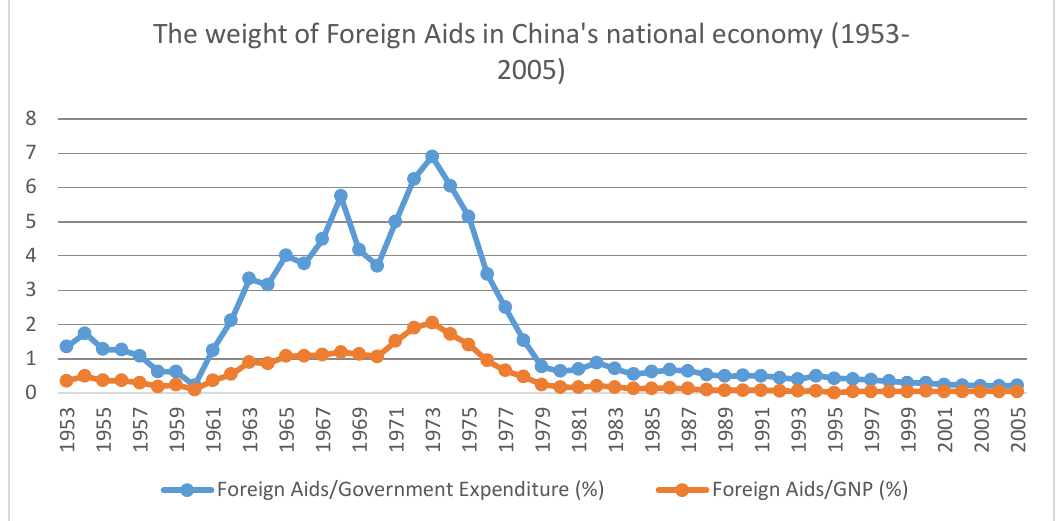
Figure 2. The weight of foreign aids in China’s national economy